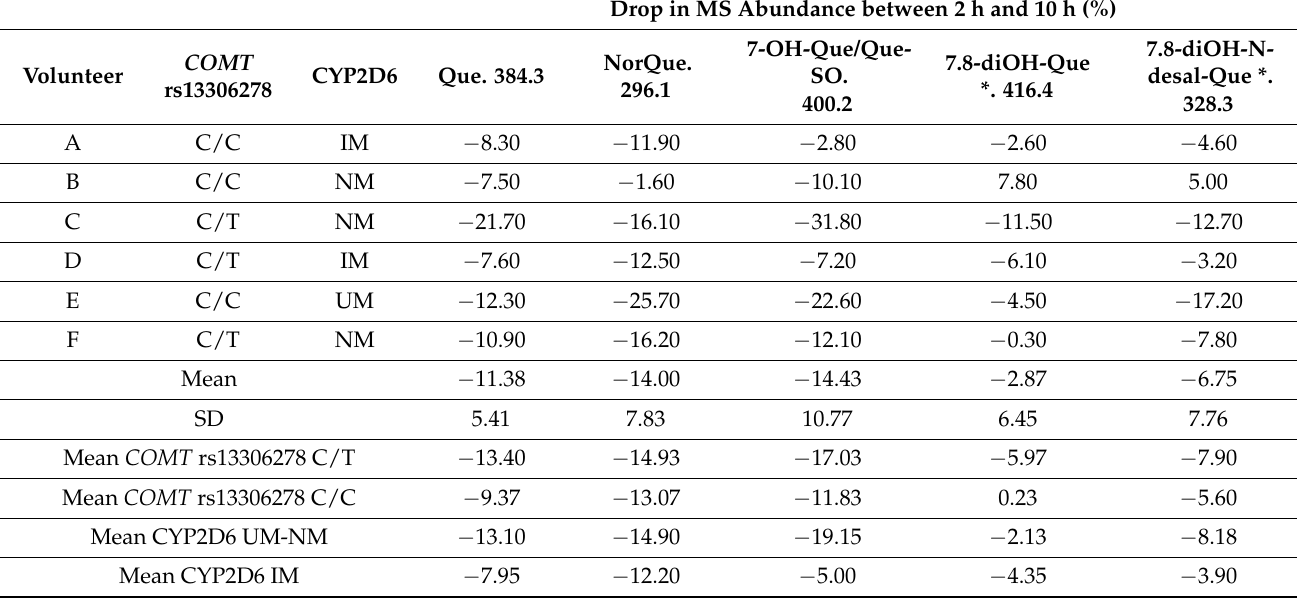
Table 5. MS abundances of quetiapine metabolites at t = 2 and t = 10 and observed variations in six healthy volunteers with specific COMT rs13306278 genotype and CYP2D6 phenotype. Drop in MS Abundance between 2 h and 10 h